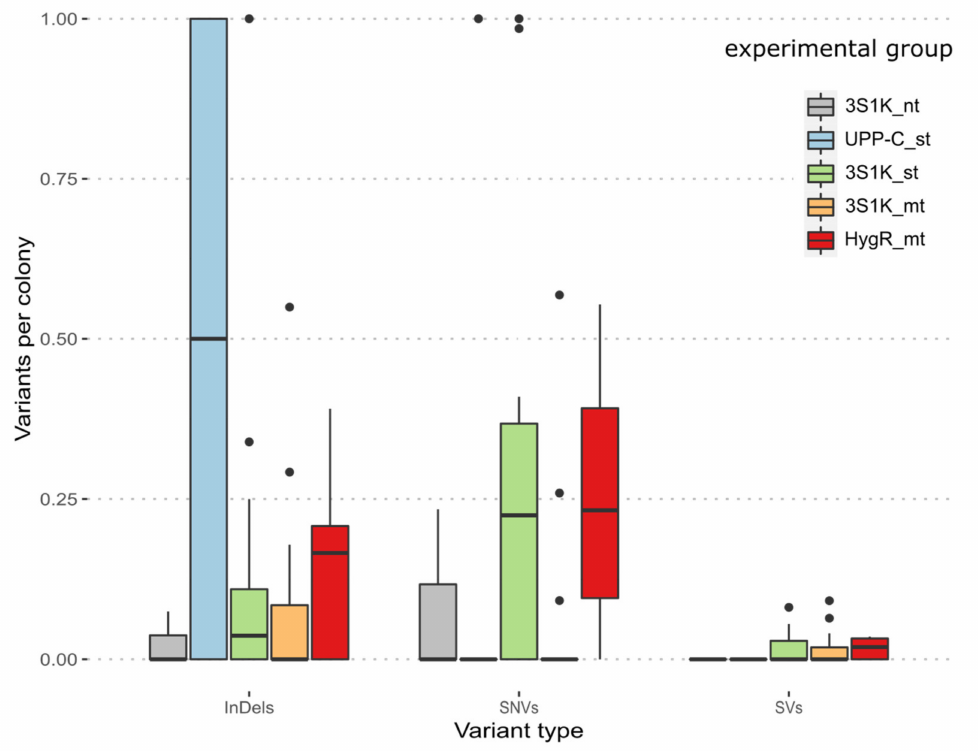
Figure 6. Boxplot of the relative frequency of variants per colony for pooled sequencing as well as single colony sequencing. Called variants were separated into the different experimental groups and included InDels, SNVs and SVs: the control group harboring no gRNA (3S1K_nt), single target groups (UPP-C_st, 3S1K_st) and the double target groups (3S1K_mt,